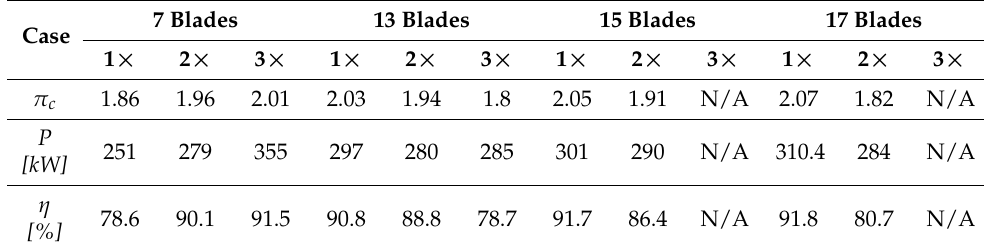
Table 3. Numerical analysis results for centrifugal impeller varying the blades number and